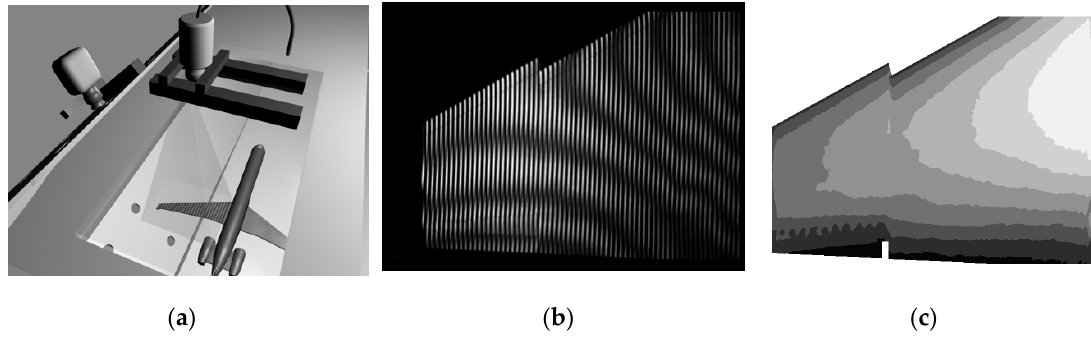
Figure 15. ( a ) measurement scheme; ( b ) Projection of mohr interference fringes; ( c ) Distribution of aircraft wing deformation [60].